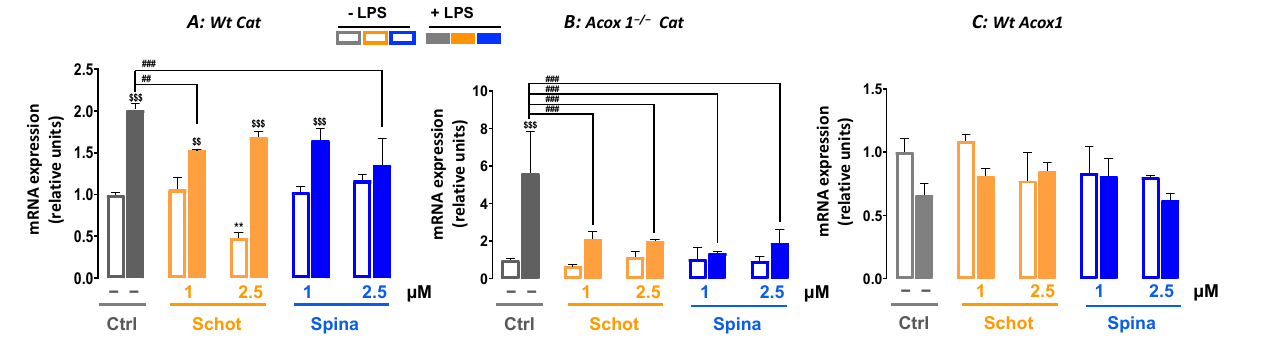
Figure 7. Effect of Schot and Spina treatment on the gene expression of Cat ( A , B ) and Acox1 ( C ) in Wt ( A , C ) and Acox1 − / − ( B ) BV-2 microglial cells. Cells were incubated for 24 h with Schot or Spina (1 or 2.5 µM) in the absence or presence of LPS (1 µg/mL). Total RNA was isolated from BV-2 cells, and then the expression level of genes of interest was quantified by real-time RT-qPCR. All values are presented as means ± SD of two independent experiments performed in triplicate, with the statistical significance of the increased mean indicated as ** p ≤ 0.01 compared to control; ### p ≤ 0.001 and ## p ≤ 0.01 compared to LPS and $$$ p ≤ 0.001 and $$ p ≤ 0.01 compared to the different treatments with or without LPS administration. Statistical significance was determined using two-way ANOVA followed by Tukey’s test for multiple comparisons.